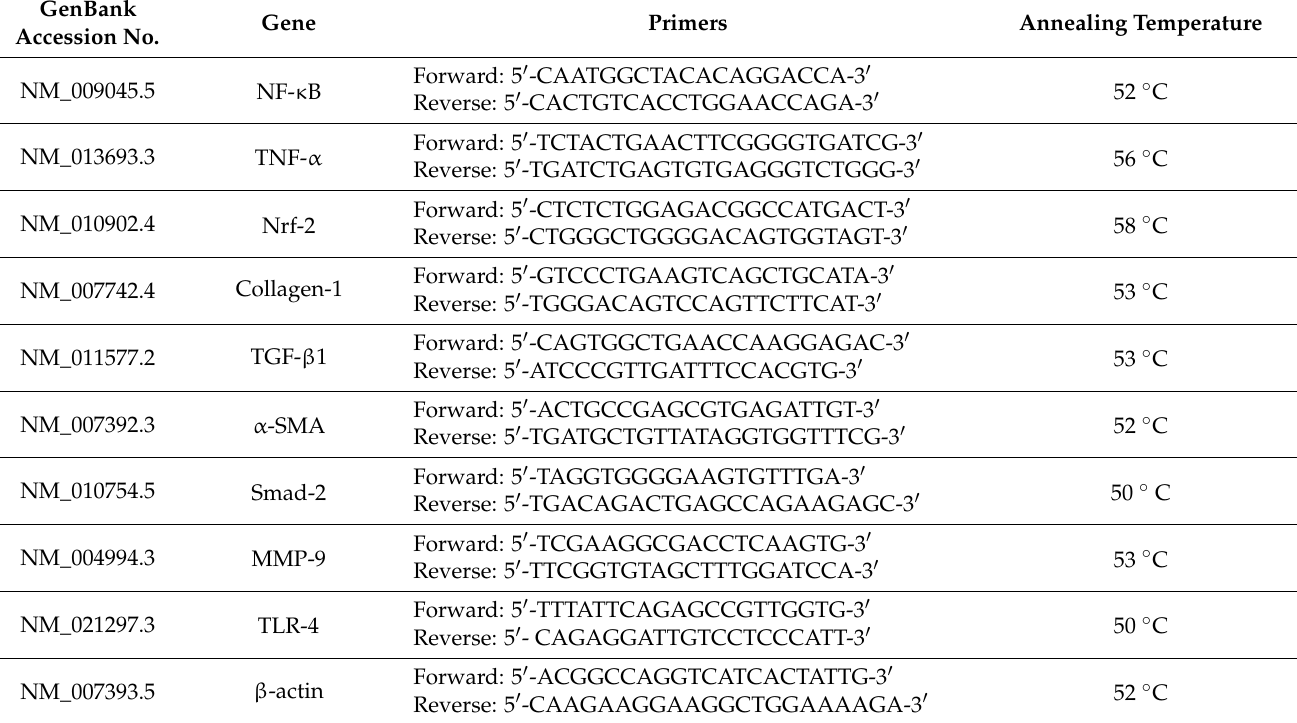
Table 1. GenBank accession numbers, primer sequences and annealing temperatures of the assessed